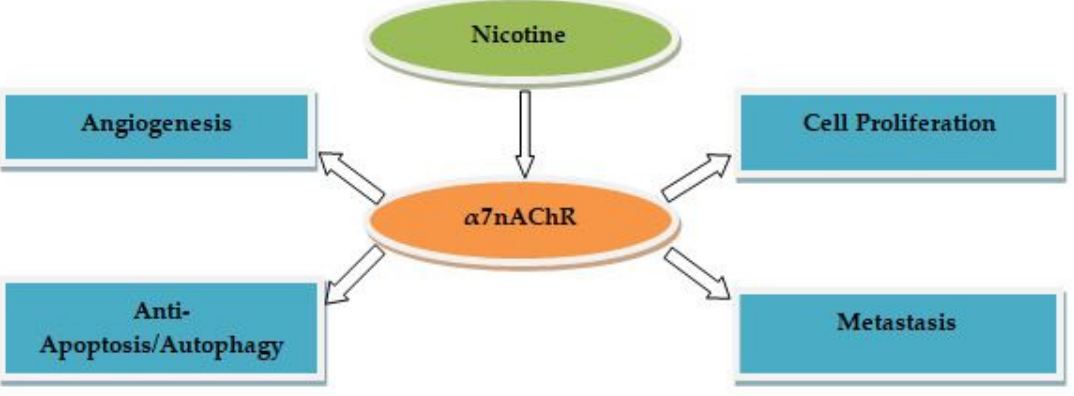
Figure 1. Mechanisms for nicotine in the development of NSCLC.